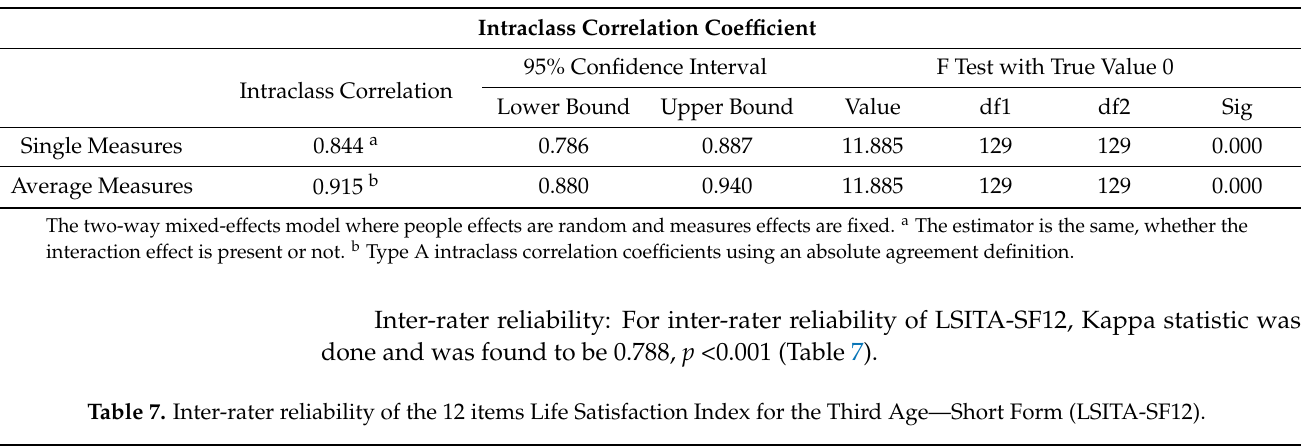
Table 6. Test-retest reliability of the 12 items Life Satisfaction Index for the Third Age—Short Form (LSITA-SF12).